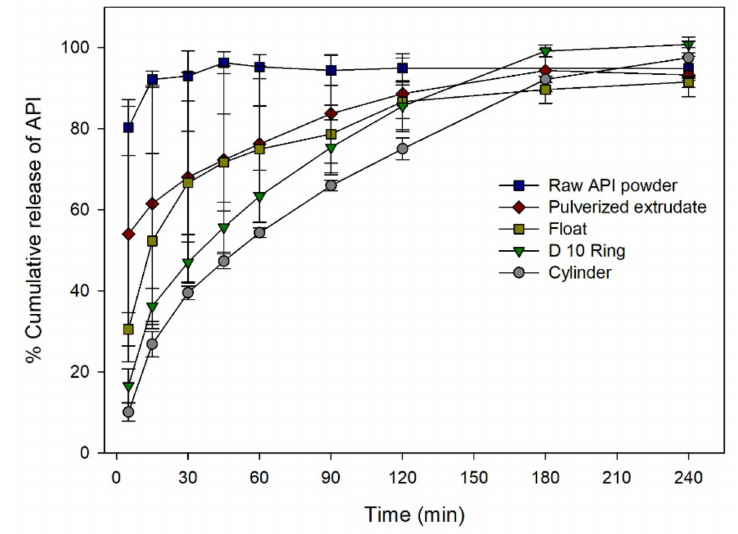
Figure 9. Dissolution rate of solid dosage forms in pH 6.8 phosphate bu ff